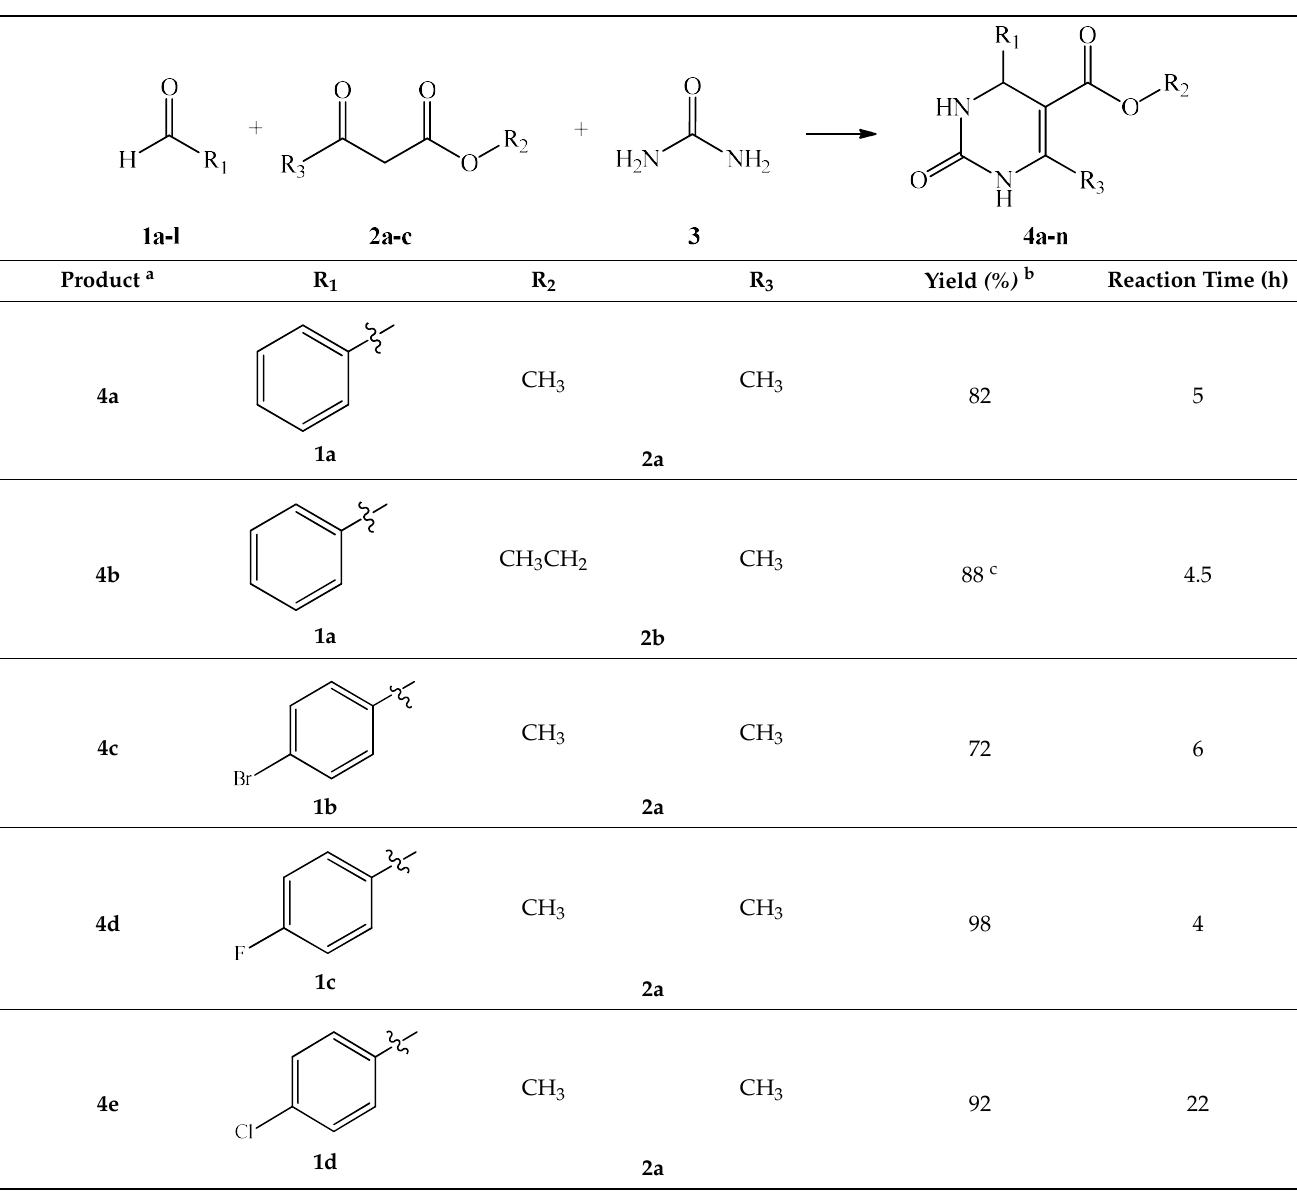
Molecules 2021 , 26 , x FOR PEER REVIEW